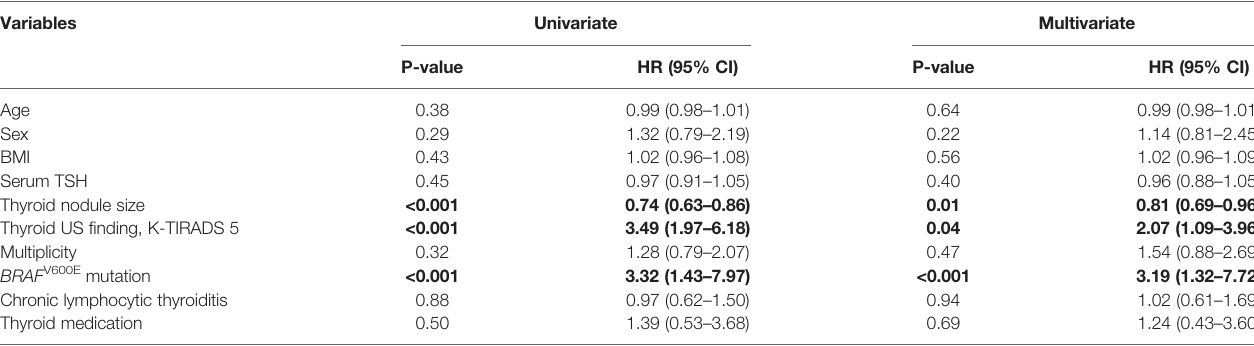
TABLE 3 | Cox regression model for the risk factors for differentiated thyroid malignancies.